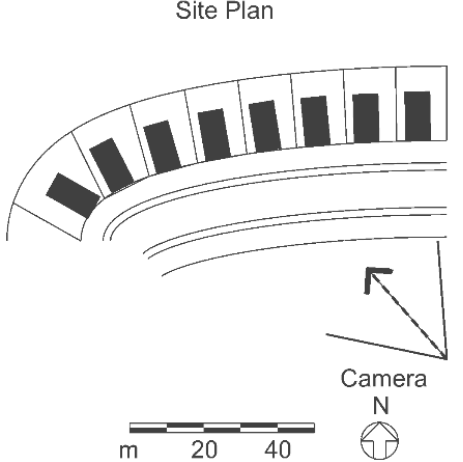
Figure 2. Site plan for the Little Boxes